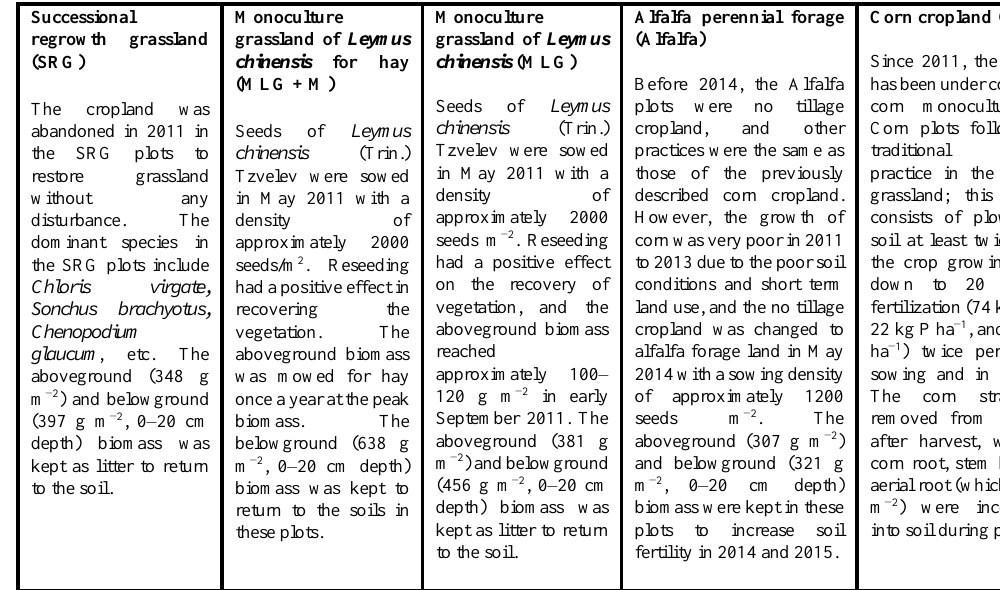
Figure 3. Detailed information and history of land use treatments in this study.